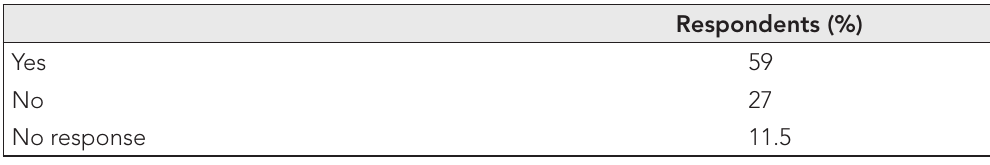
Table 9: Main reasons for changes Increased interest and awareness 32 Willingness to teach/be involved in global issues